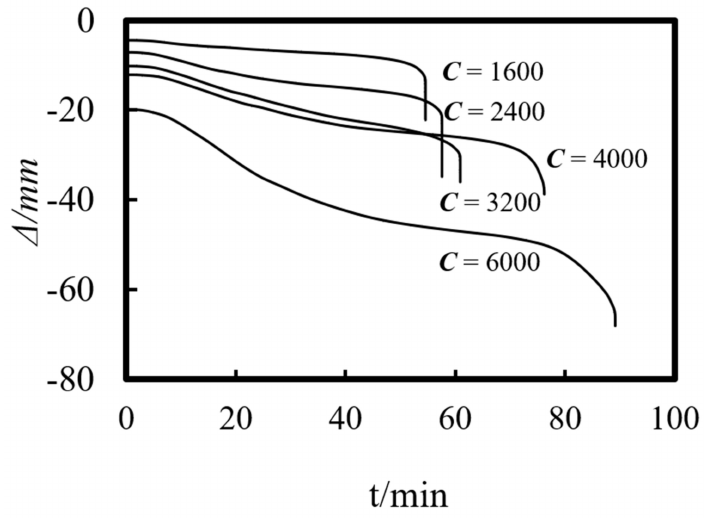
Figure 18. Effect of perimeter on the axial deformation − time curve.